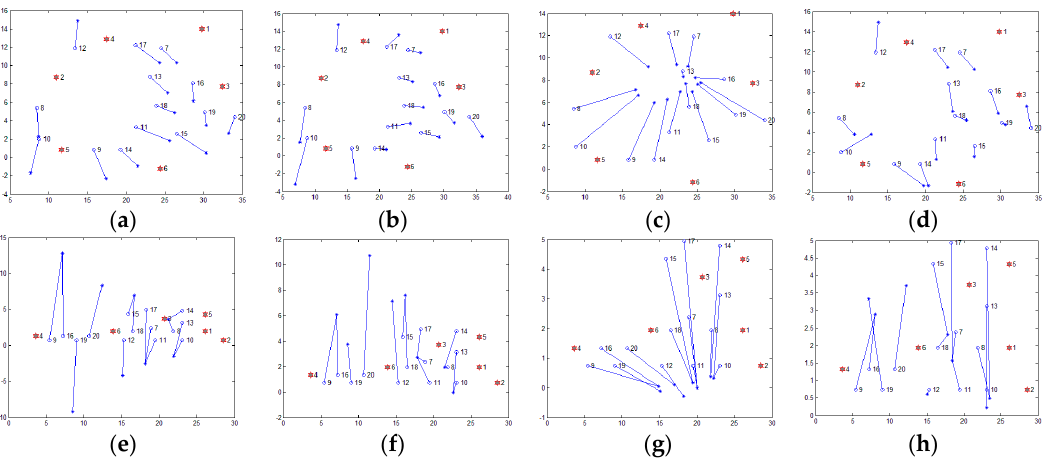
Figure 14. Results of location estimation in realistic scenarios ( a ) DV-hop in the outdoor, RMS = 3.1446; ( b ) PDM in the outdoor, RMS = 3.0085; ( c ) LSVR in the outdoor, RMS = 5.7151; ( d ) ML-RELM in the outdoor, RMS = 2.6829; ( e ) DV-hop in the indoor, RMS = 6.6422; ( f ) PDM in the indoor, RMS = 4.4114; ( g ) LSVR in the indoor, RMS = 5.0065; ( h ) ML-RELM in the indoor, RMS = 2.5197.